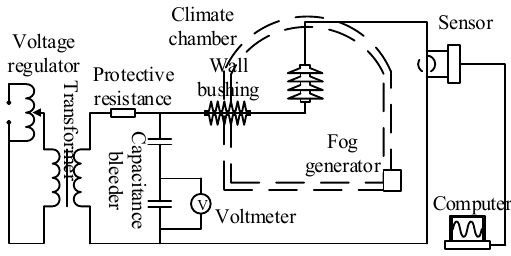
Figure 13. Schematics of the artificial pollution test.